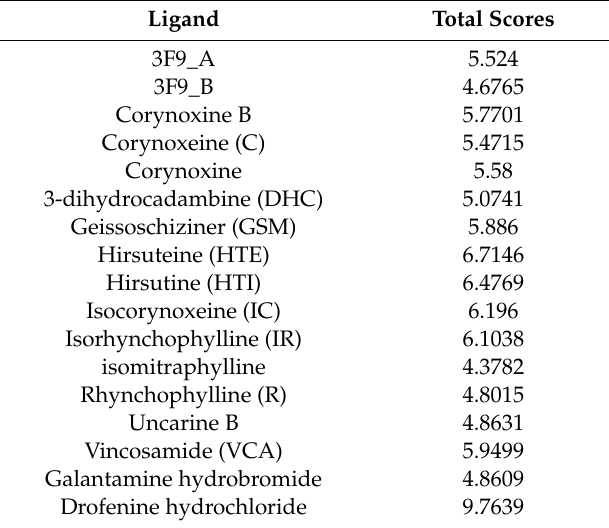
Table 3. In vitro BChE enzyme activity assay of five selected Uncaria alkaloids.